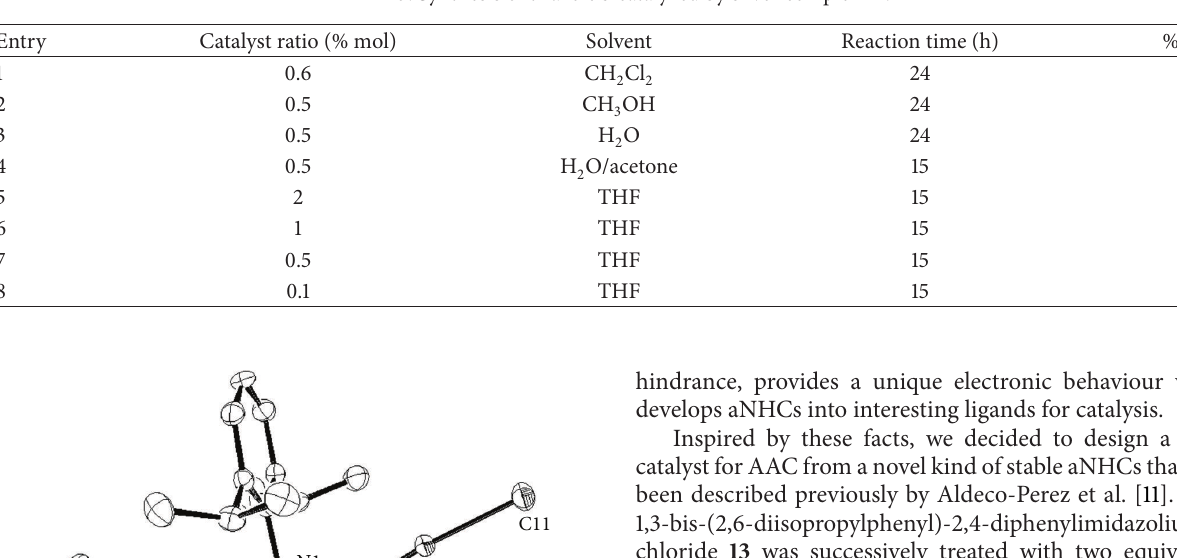
Table 3: Synthesis of triazole 3 catalyzed by silver complex 14 .